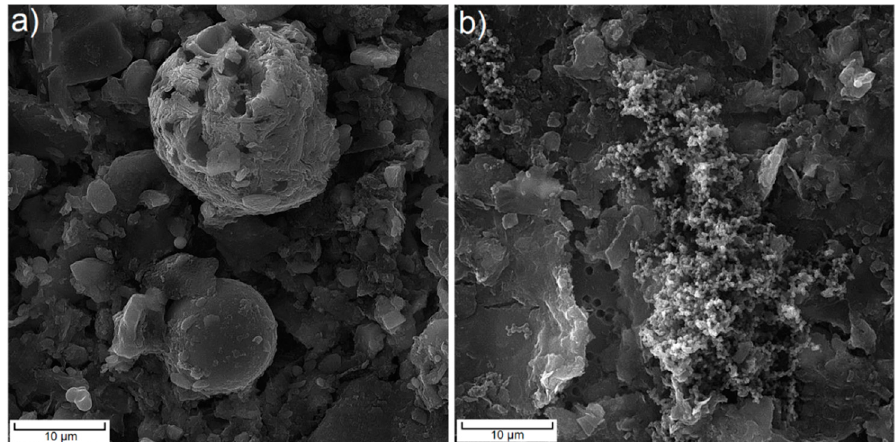
Figure 6. The composition of the SPM in snow in Pikalevo Lake (scanning electron microscope data). ( a ) The fly ash of liquid fuel with a loose nosy surface and aluminosilicate coal ash of a thermal power plant with a smooth spherical surface; ( b ) loose aggregate of soot particles.